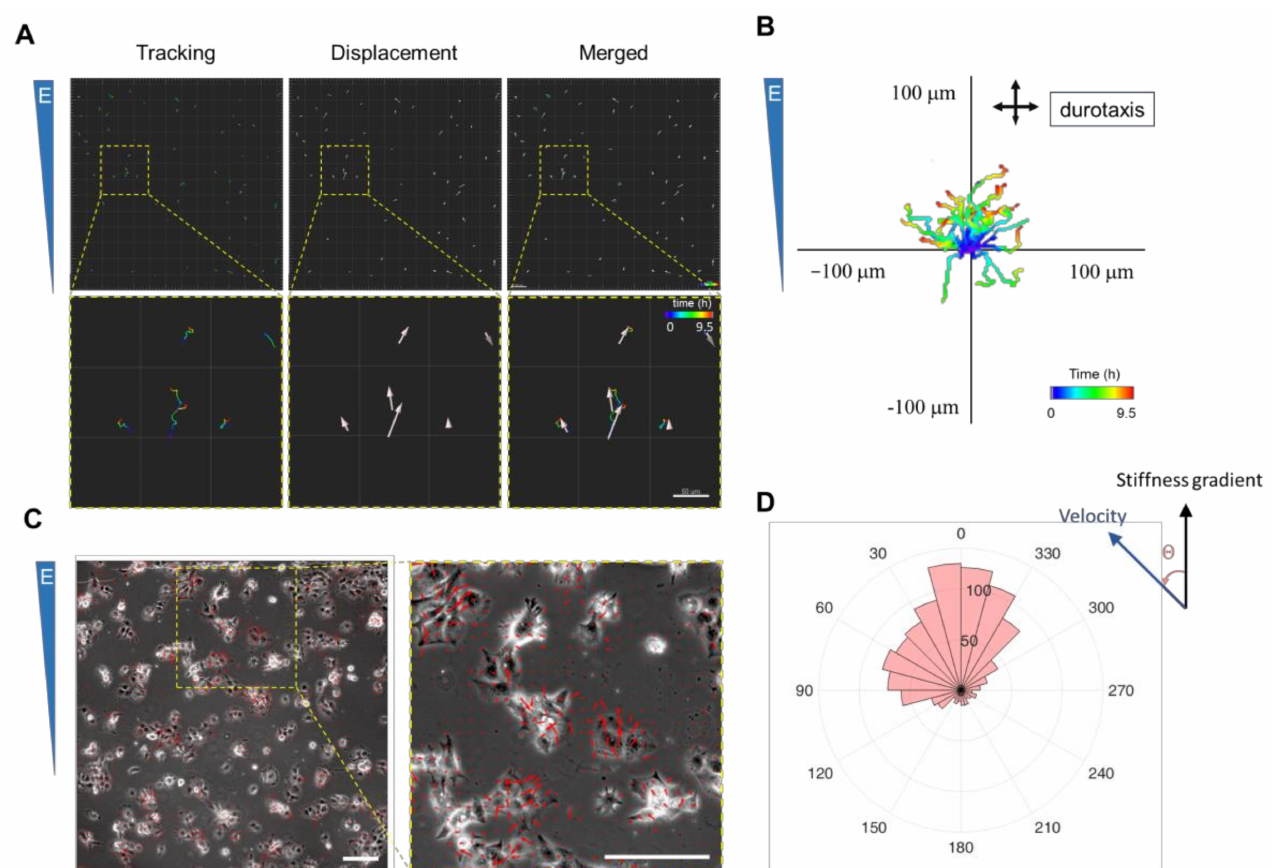
Figure 4. JAR cells exhibit durotaxis. ( A ) Tracking of JAR cells cultured on stiff region (scale bar: 50 µ m, time bar: 9.5 h). E indicates the apparent Young’s modulus. Arrows indicated the displacement of each cell, ( B ) Representative JAR cell migration plots on stiff region over 9.5 h. The total cell number n = 56, number of independent experiments N = 3. ( C ) Vector map of JAR cell migration on stiff region (scale bar: 150 µ m). Arrows indicated the vector of velocity. ( D ) Rose diagram of cell migration direction, which displays the angular between migration and stiffness gradient and the frequency of each class. The total cell number n = 56, number of independent experiments N =